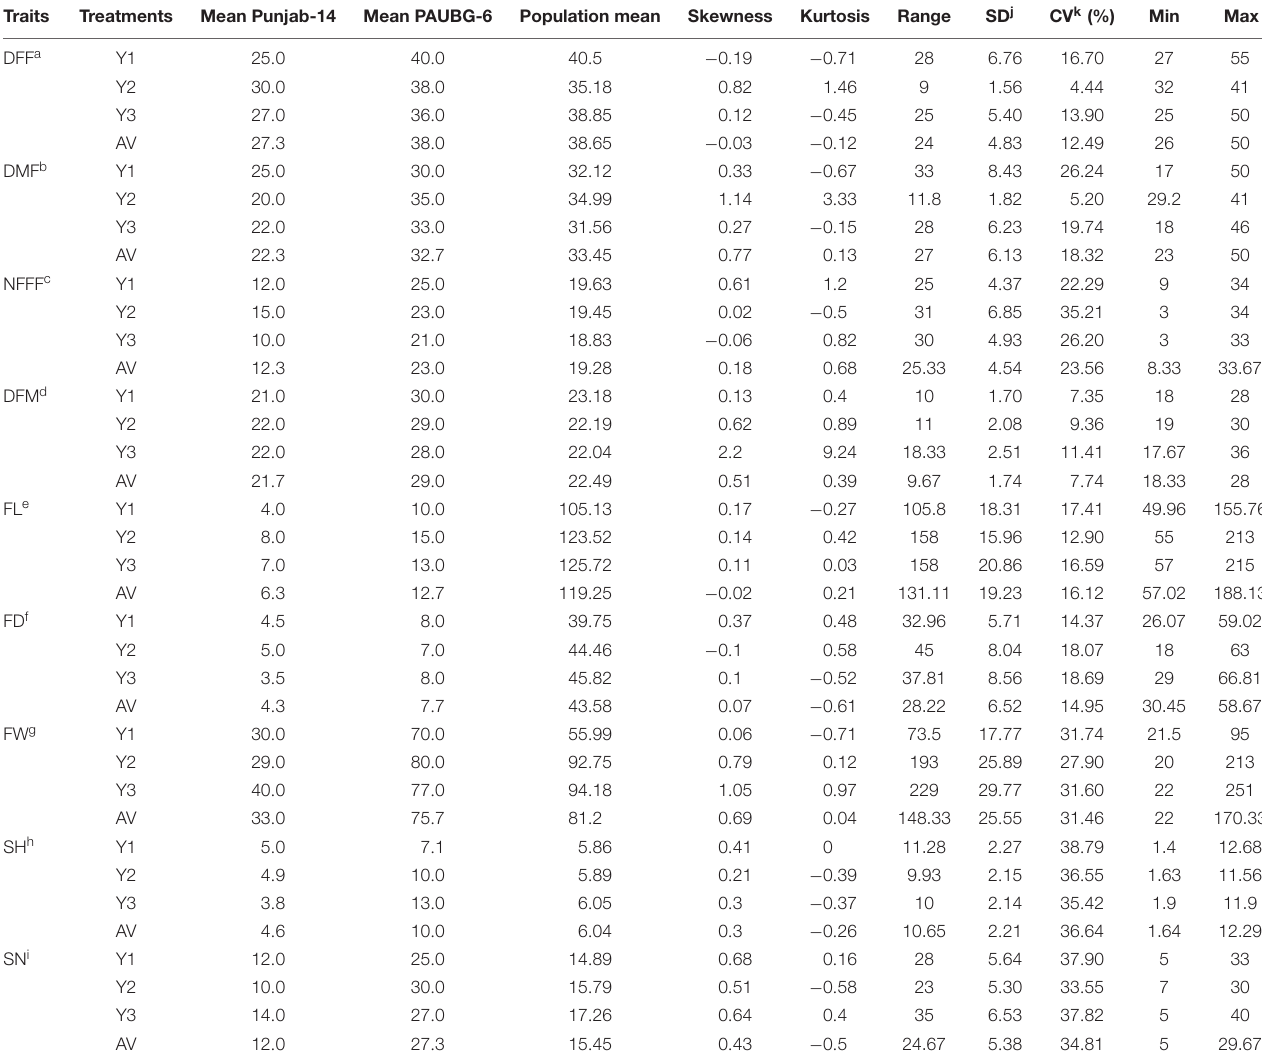
TABLE 1 | Phenotypic performance of the F 4 population under Y1, Y2, Y3, and their average values (AV) environments. Traits Treatments Mean